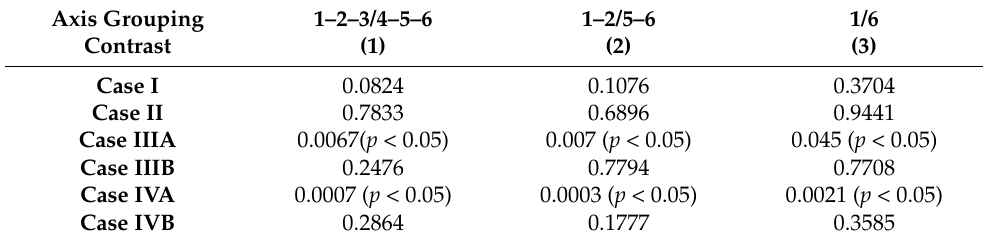
Table 5. Significance of orthogonal contrasts of temperature values.